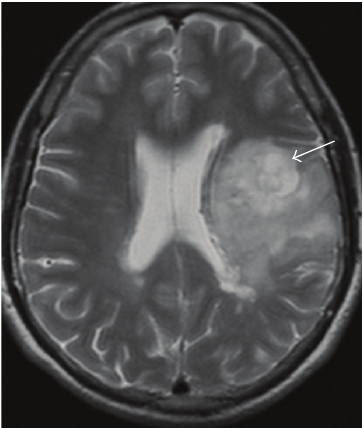
Figure 1: Cerebral MRI (2003): large left frontal lobe lesion (arrow) suggesting a tumefactive demyelinating